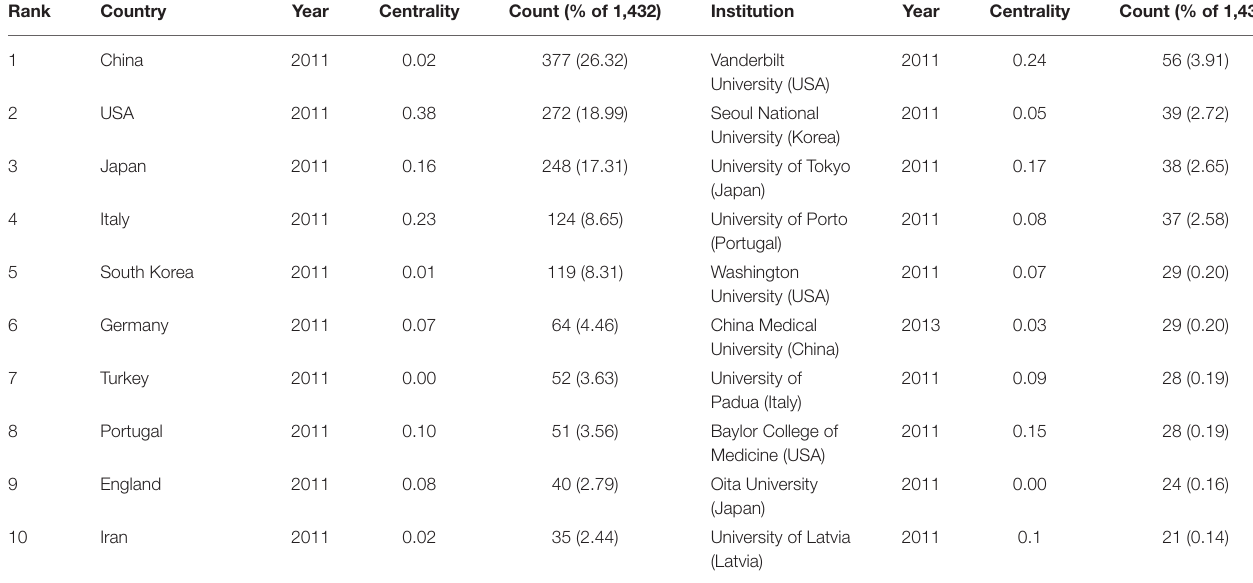
TABLE 1 | The top 10 countries or regions and institutions involved in atrophic gastritis (AG) research.